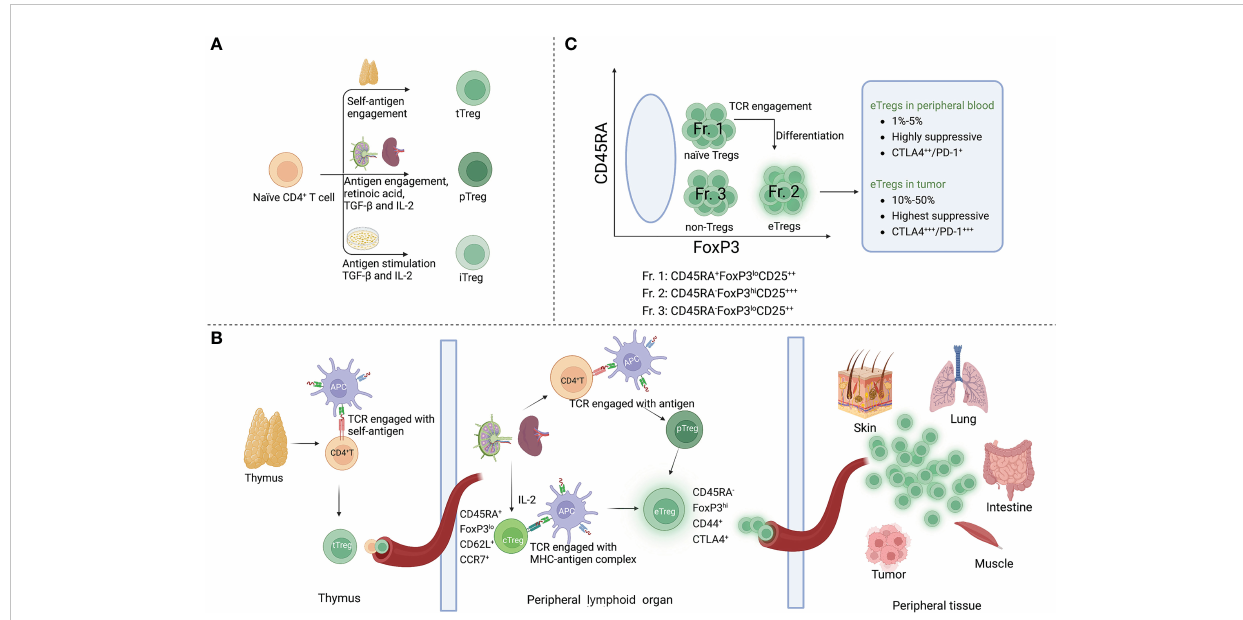
FIGURE 1 Phenotype and development of Tregs. (A) There are three Treg subtypes according to the sites of development: tTregs are developed in the thymus from the precursors of CD4 + T cells; pTregs are differentiated from mature CD4 + Th cells in the periphery upon encounter with antigens and other factors (IL-2, TGF- b , and retinoic acid); iTregs are developed from naïve T cells and require antigen stimulation in the presence of TGF- b and IL-2. (B) Development of cTregs and eTregs: tTregs migrate to peripheral lymphoid organs after thymus development and become cTregs, maintaining a naïve phenotype in the presence of IL-2 (CD45RA + , FOXP3 lo , CD62L + , CCR7 + ). When cTregs and pTregs encounter TCR stimulation, they further differentiate into eTregs with expression of activation molecules CD44 and CTLA4. eTregs migrate and localize to non-lymphoid peripheral sites in response to speci fi c stimuli. (C) Subfractions of human FOXP3 + Tregs: Fr. 1, CD45RA + FOXP3 lo CD25 ++ naïve Tregs; when naïve Tregs engage with antigens, they differentiate into Fr. 2 eTregs (CD45RA - FOXP3 hi CD25 +++ ); Fr. 3, non-Tregs, de fi ned by CD45RA - FOXP3 lo CD25 ++